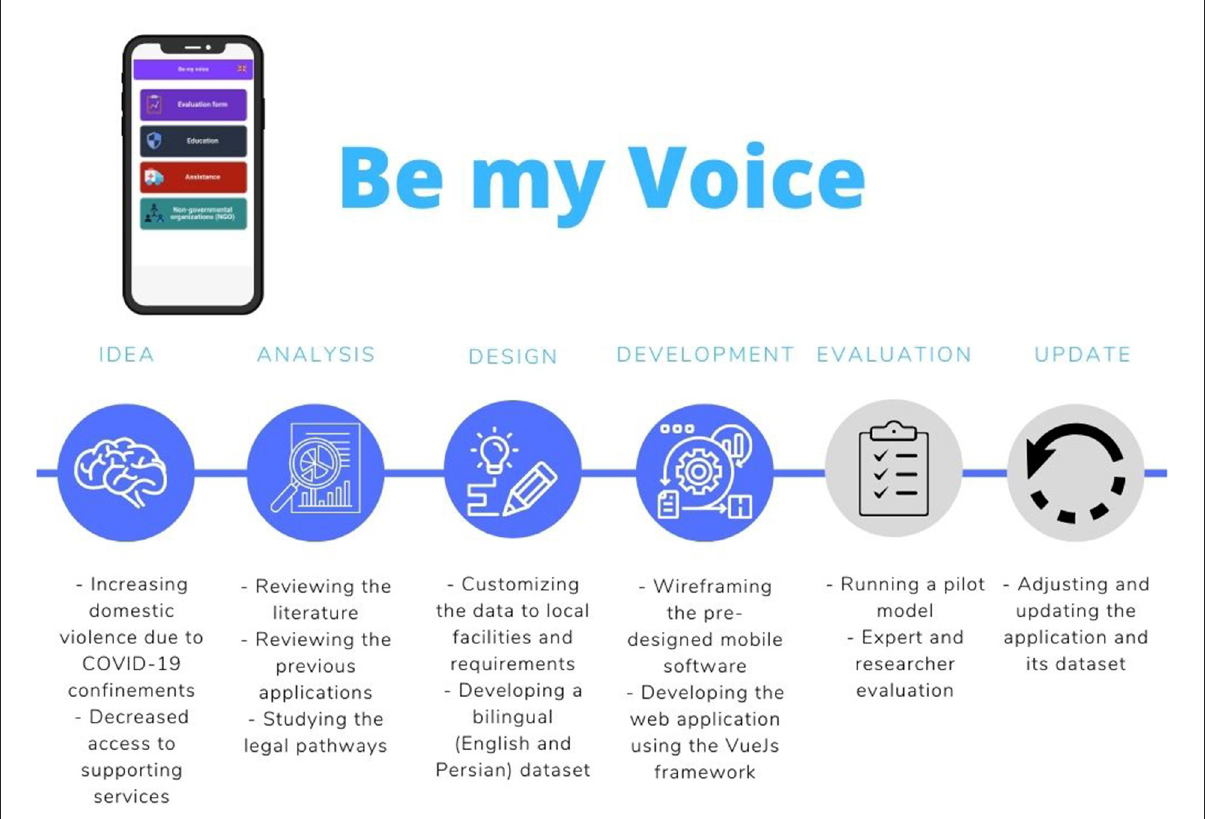
FIGURE1 Different stages of developing Be my Voice